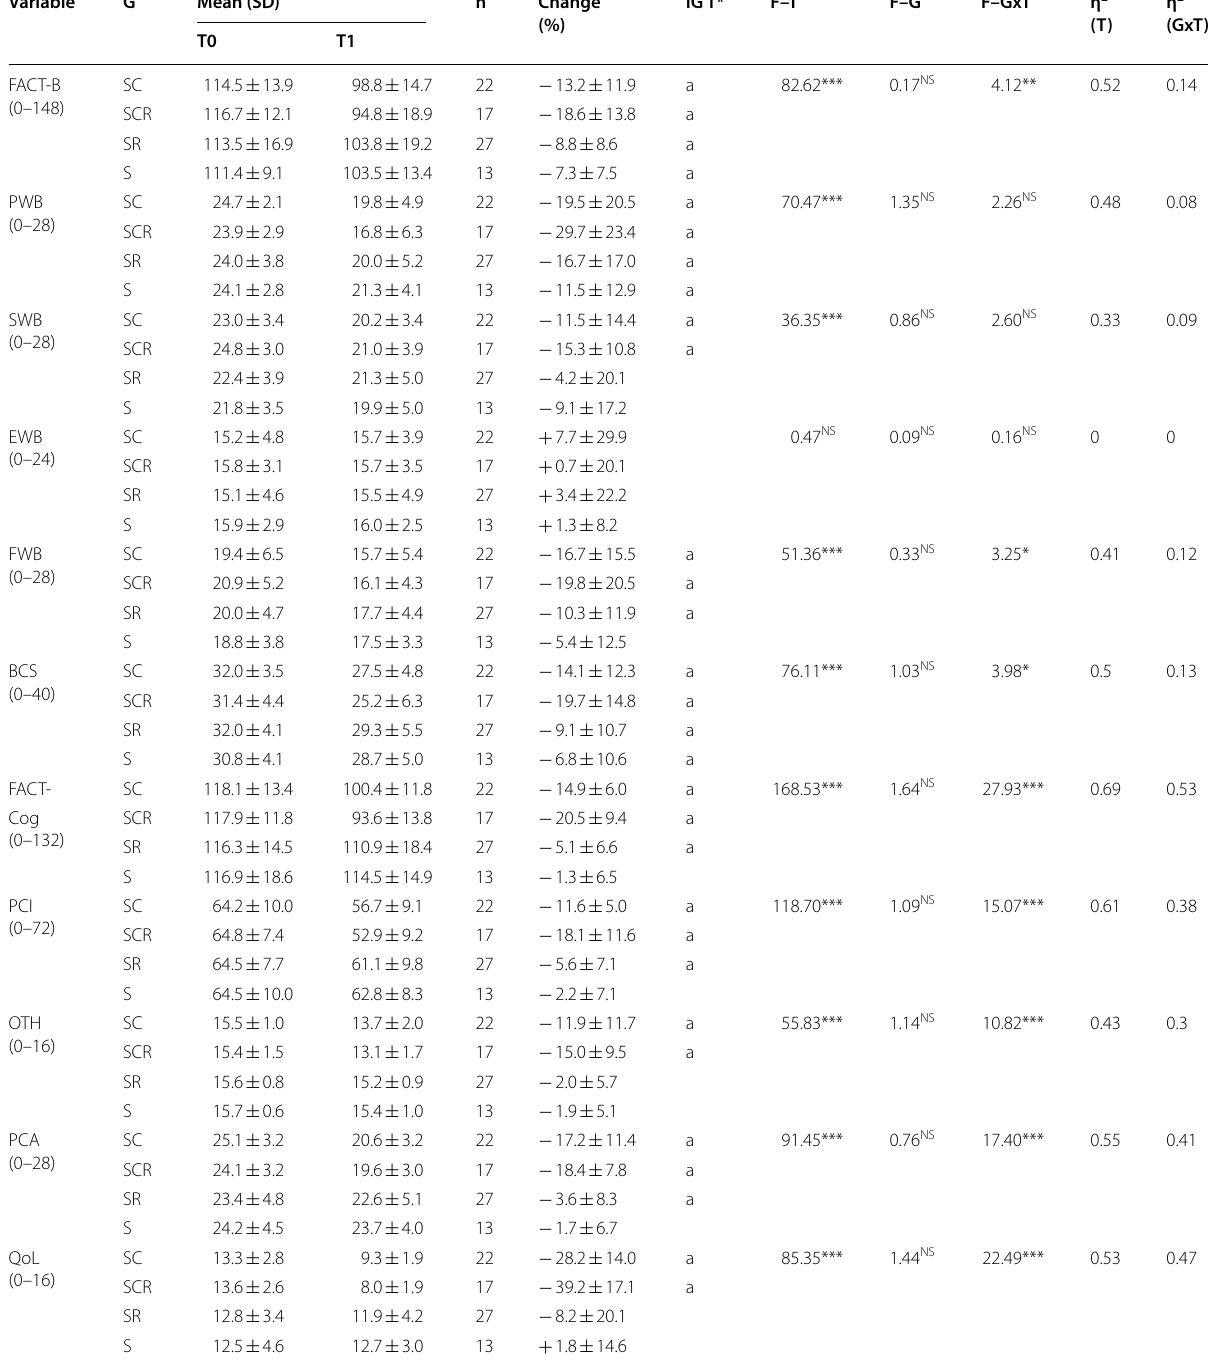
Table 4 The primary outcome measures of the FACT‑B and the FACT‑Cog in the treatment